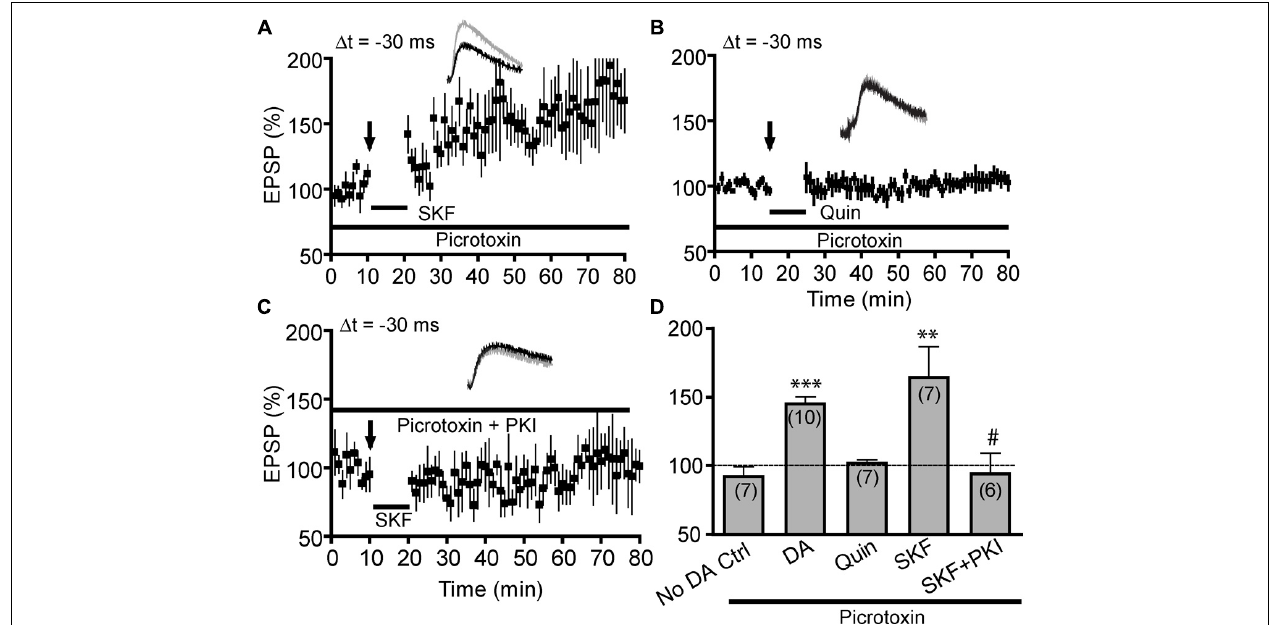
− 30 ms. (C) SKF81297-enabled t-LTP was abolished by intracellular loading of PKI (6–22; 20 μ M). (D) Summary of t-LTP at Δ t = − 30 ms under different conditions. ** P < 0.01; *** P < 0.001 vs. No DA control; # P < 0.05 vs. SKF. Student’s t -tests. Data for “No DA Ctrl” and “DA” was re-plotted from Figures 3A,B for direct